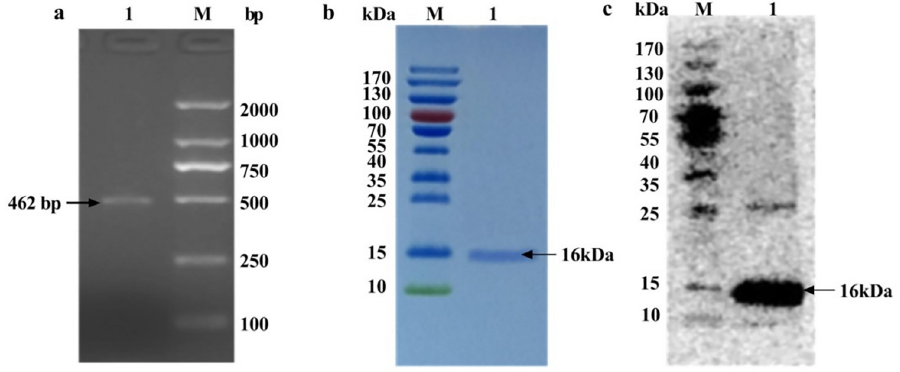
Fig 2. Gene cloning and expression of the loaded antigen P6. A Amplification product for the NTHi-P6 gene by PCR. Lane 1 P6 gene, Lane M DNA ladder DL2000. B SDS-PAGE gel analysis of tag-removed P6 protein expressed from the NTHi-P6 gene. Lane 1 P6 protein, Lane M prestained protein ladder. C Western blot analysis of tag-removed P6. Lane 1 polyclonal antibodies against P6, Lane M prestained protein